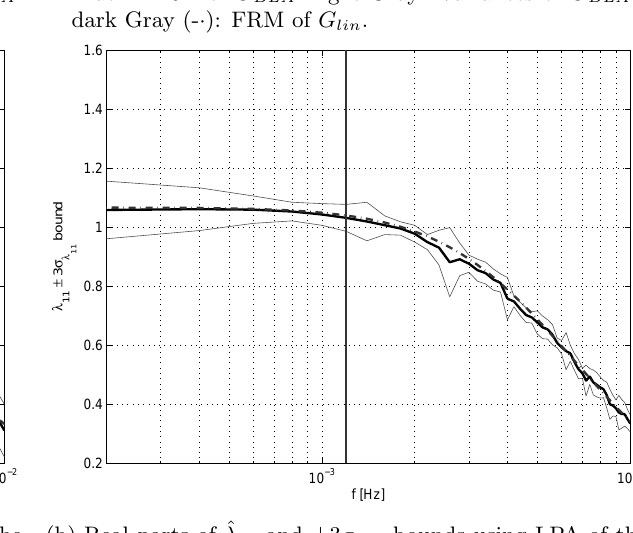
(a) Estimated FRM of G BLA using LPA of the simulated case with random excitation. Black: FRM of ˆ G BLA . light Gray: Variances of ˆ G BLA . dark Gray (- · ): FRM of G lin .